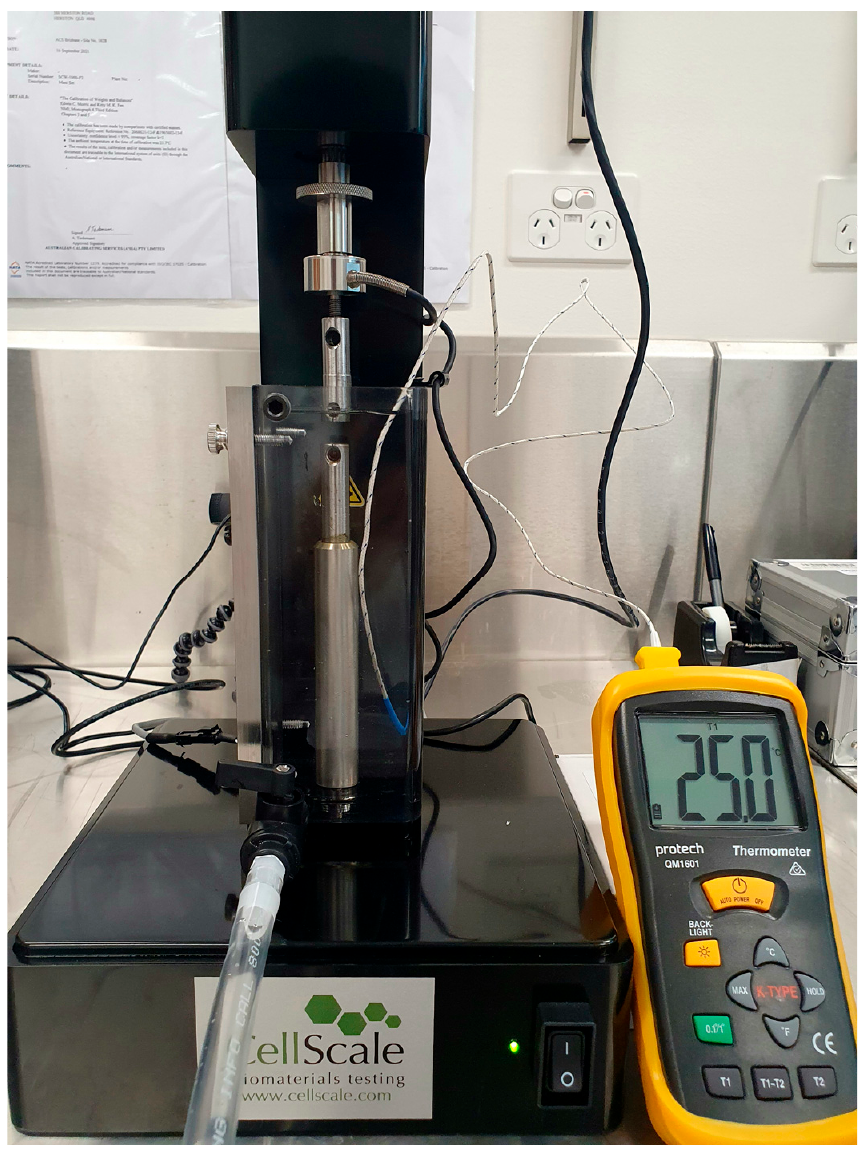
Figure 5. Photograph of UniVert microtensile test setup used .